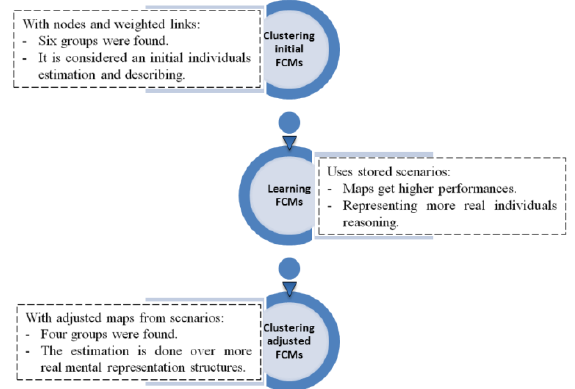
Fig. 10. Decision making analysis procedure.